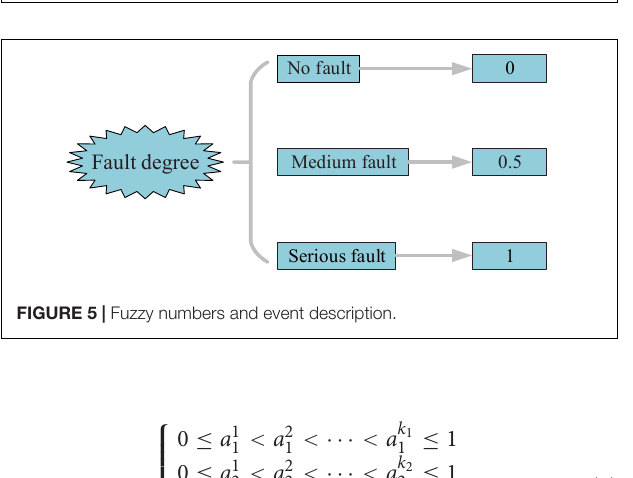
FIGURE 4 | T–S fuzzy fault tree model.